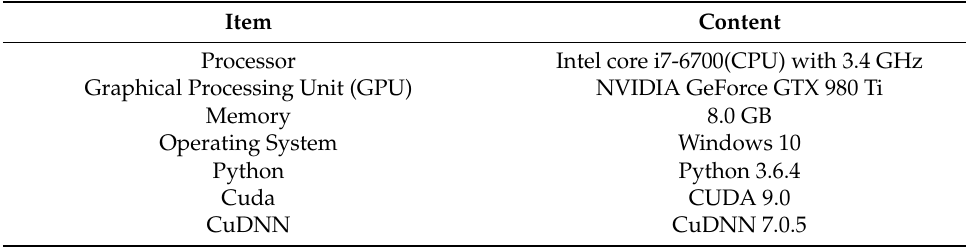
Table 2. Hardware and